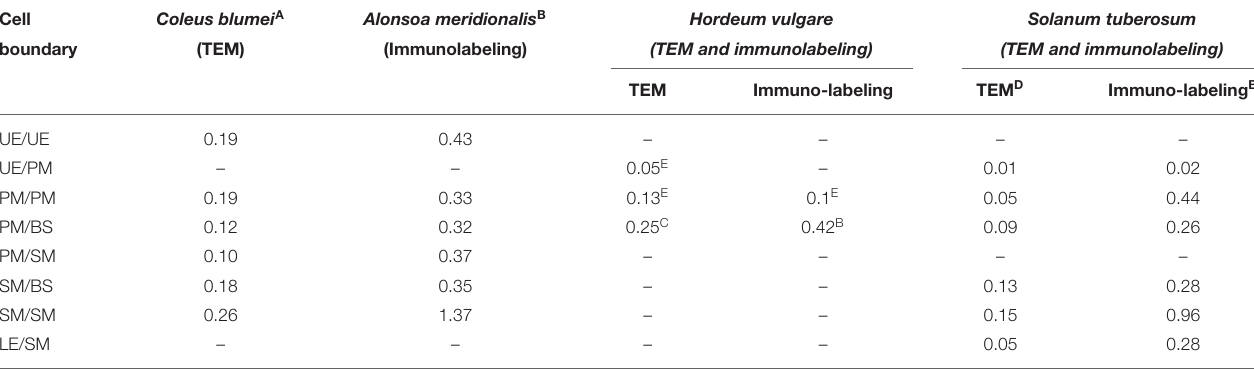
TABLE 2 | Comparison of the numbers of immunolabeled PD/pitfields with PD frequencies (PD µ m − 1 length CW) determined in leaves of several species by means of immunolabeling (this study) and TEM (literature data), respectively.